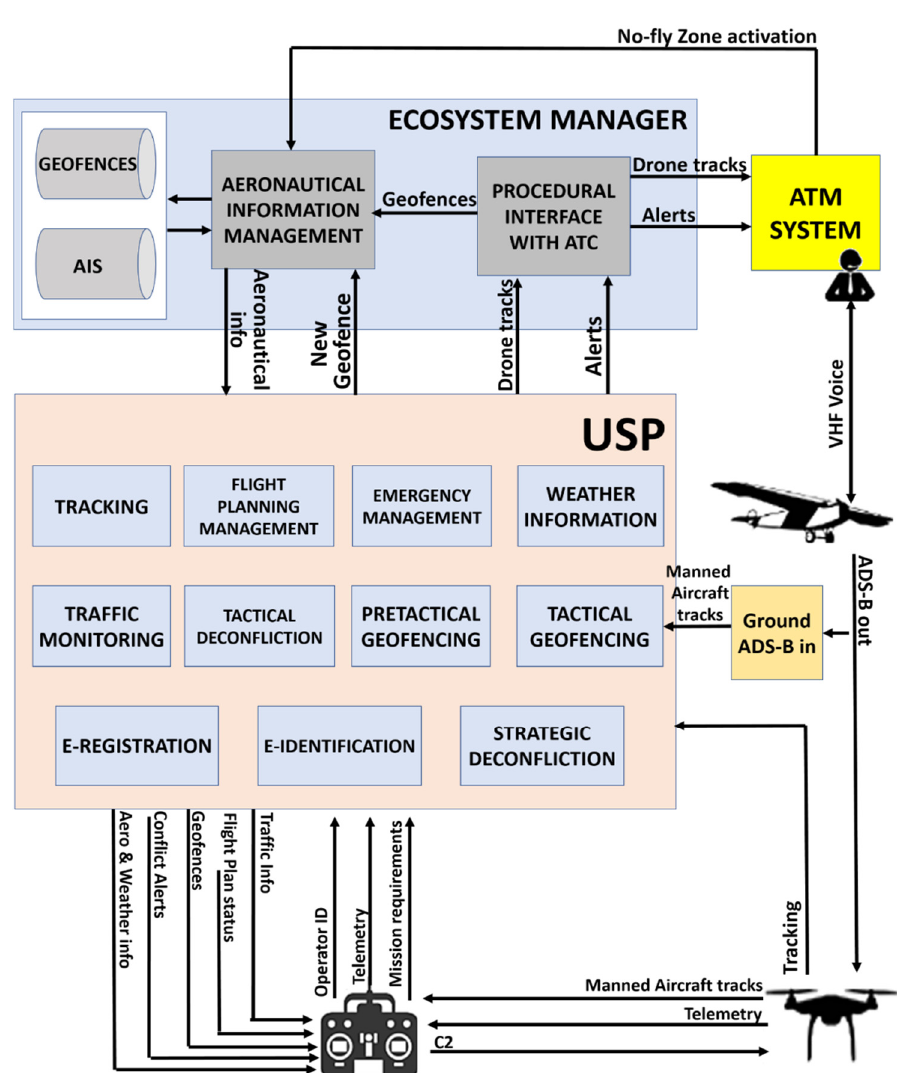
Figure 1. Main actors involved in the demonstrations and high-level architecture of the U-space platform that provided proof-of-concept implementation of most of the initial U-space services within the USP (U-space Service Provider system).